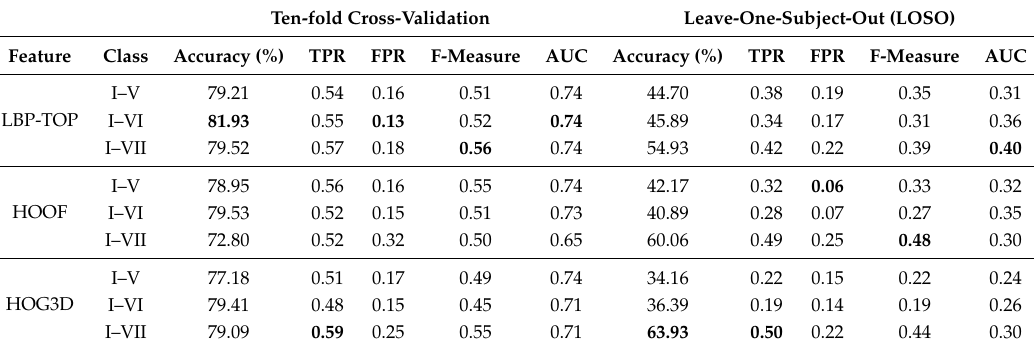
Table 5. Results on the SAMM dataset showing each feature and proposed